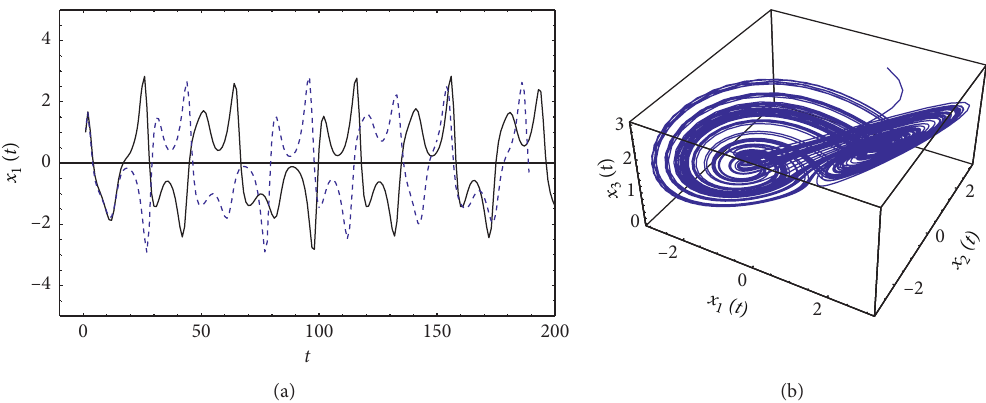
Figure 1: (a) Two numerically calculated solutions of (1) for a ( 0 ) � 3 (solid curve) and x x 3 at t � 15, clearing the chaotic manner of the system orbits. (b) 3-dimensional chaotic attractor in ( x